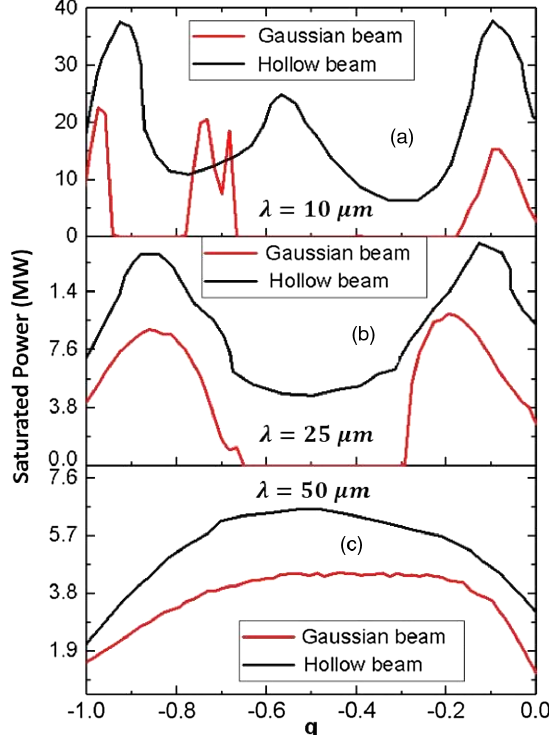
FIG. 4. Variation of out-coupled saturated power with cavity stability parameter g , for Gaussian and hollow electron beams, for